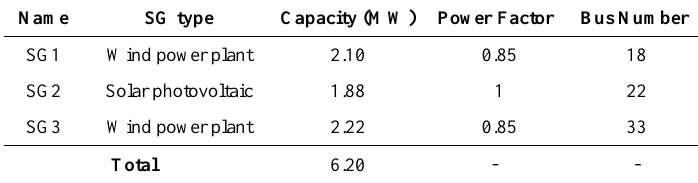
Table 1. Location and capacity of SG in IEEE model distribution network 33-bus.